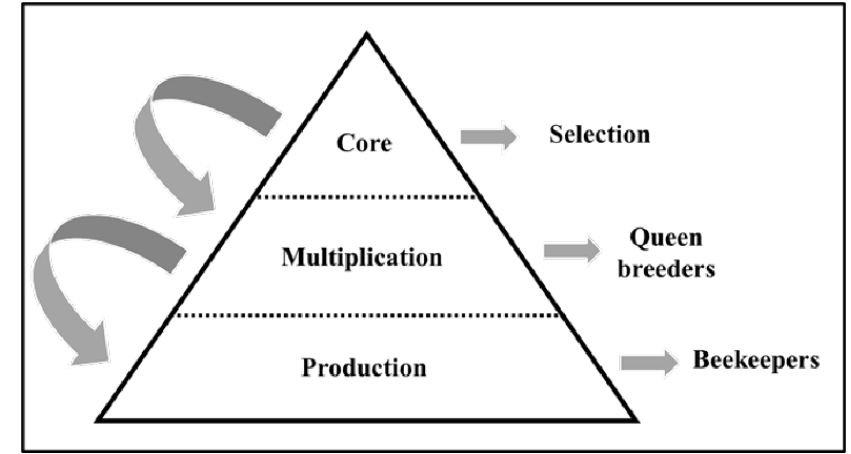
Figure 5. Selection pyramid and distribution patterns of genetic progress.